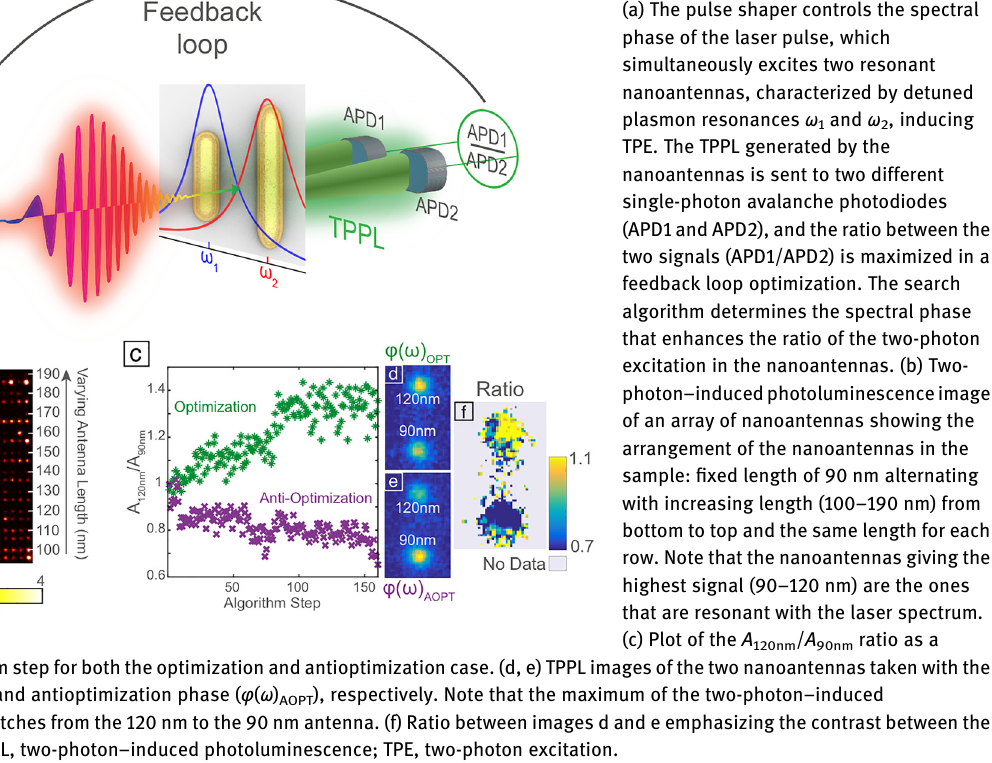
Figure 2: Closed-loop control experiment. (a) The pulse shaper controls the spectral phase of the laser pulse, which simultaneously excites two resonant nanoantennas, characterized by detuned plasmon resonances ω 1 and ω 2 , inducing TPE. The TPPL generated by the nanoantennas is sent to two different single-photon avalanche photodiodes (APD1 and APD2), and the ratio between the two signals (APD1/APD2) is maximized in a feedback loop optimization. The search algorithm determines the spectral phase that enhances the ratio of the